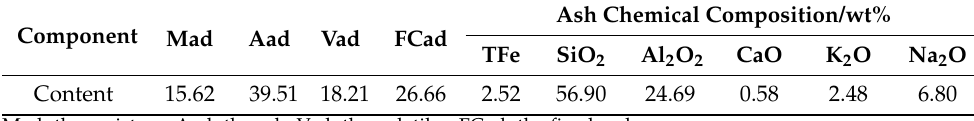
Table 2. Industrial analysis of humic acid-based binder and the chemical composition of the binder ash/wt%. Component